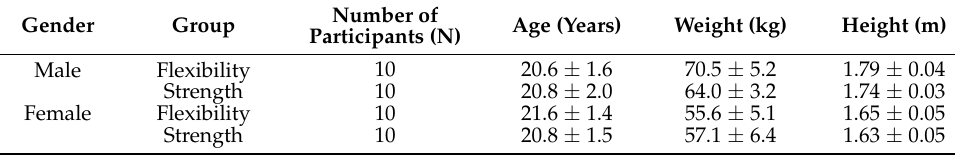
Table 1. Participant demographic characteristics (mean ± standard deviation).